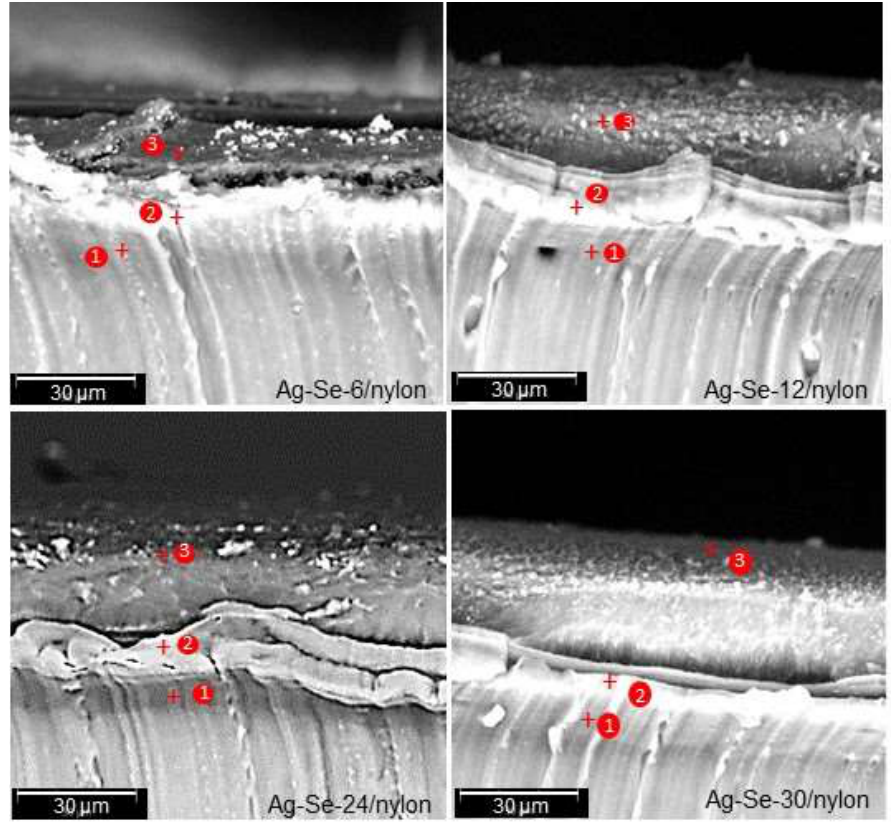
Figure 3. Cross-sectional micrographs of Ag–Se/nylon samples with marked points where the elemental composition was determined by Phenom ProX-SEM-EDS. Table 2. Fractional thickness of Ag–Se film layers on nylon.